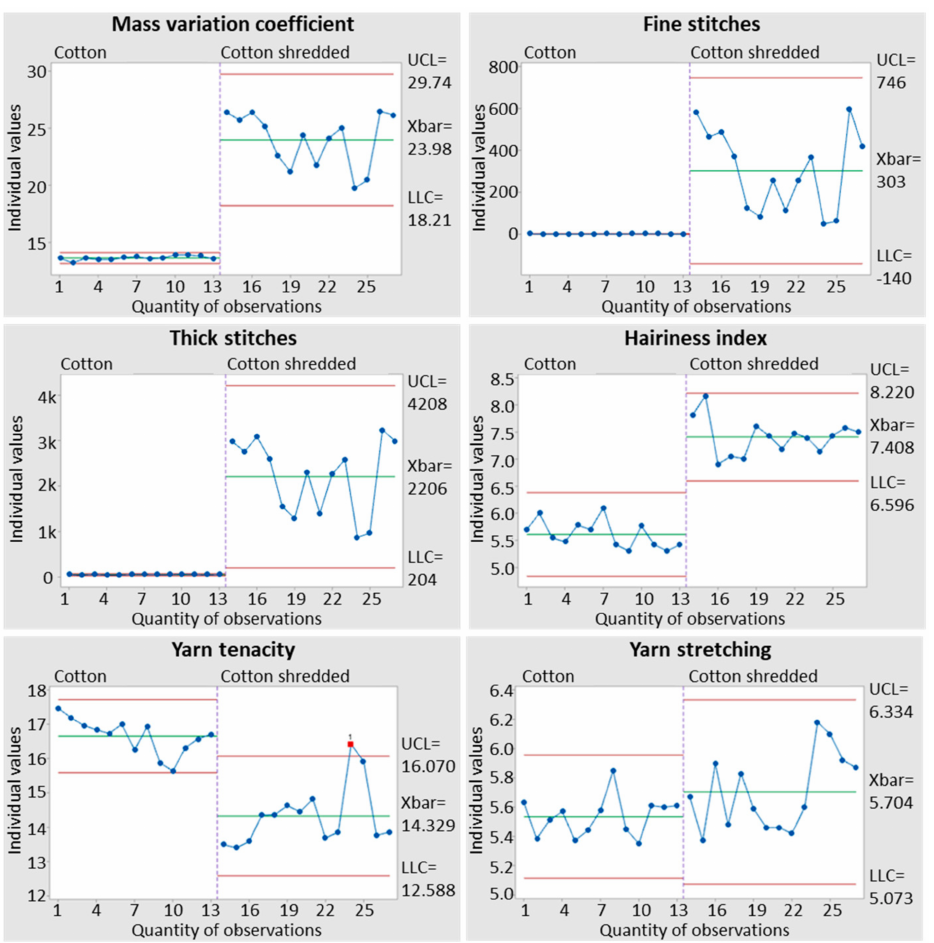
Figure 5. Comparative analysis for thread, produced from 100% cotton and from cotton